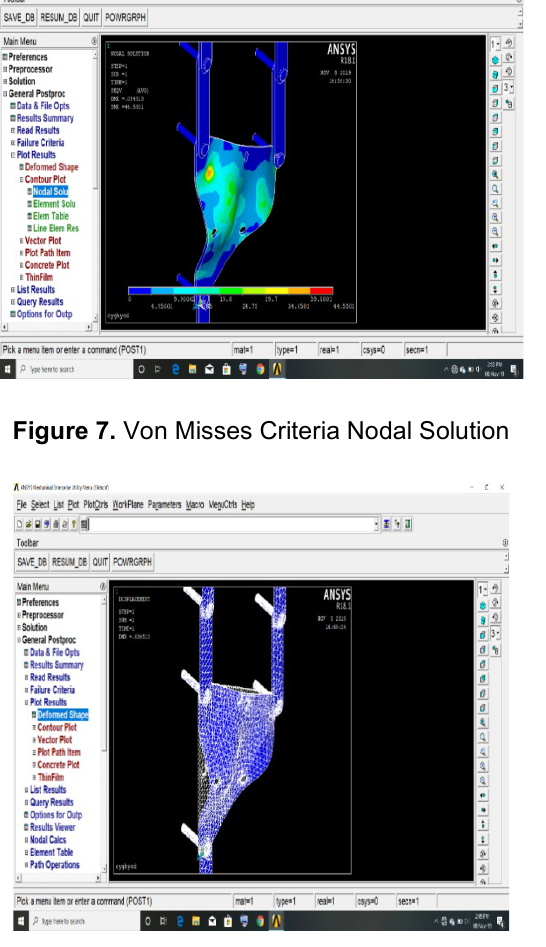
Figure 8. The stress analysis of 3RRR planar parallel manipulator